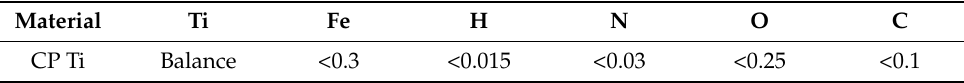
Table 1. Chemical composition of commercially pure titanium (CP Ti) in wt.%.